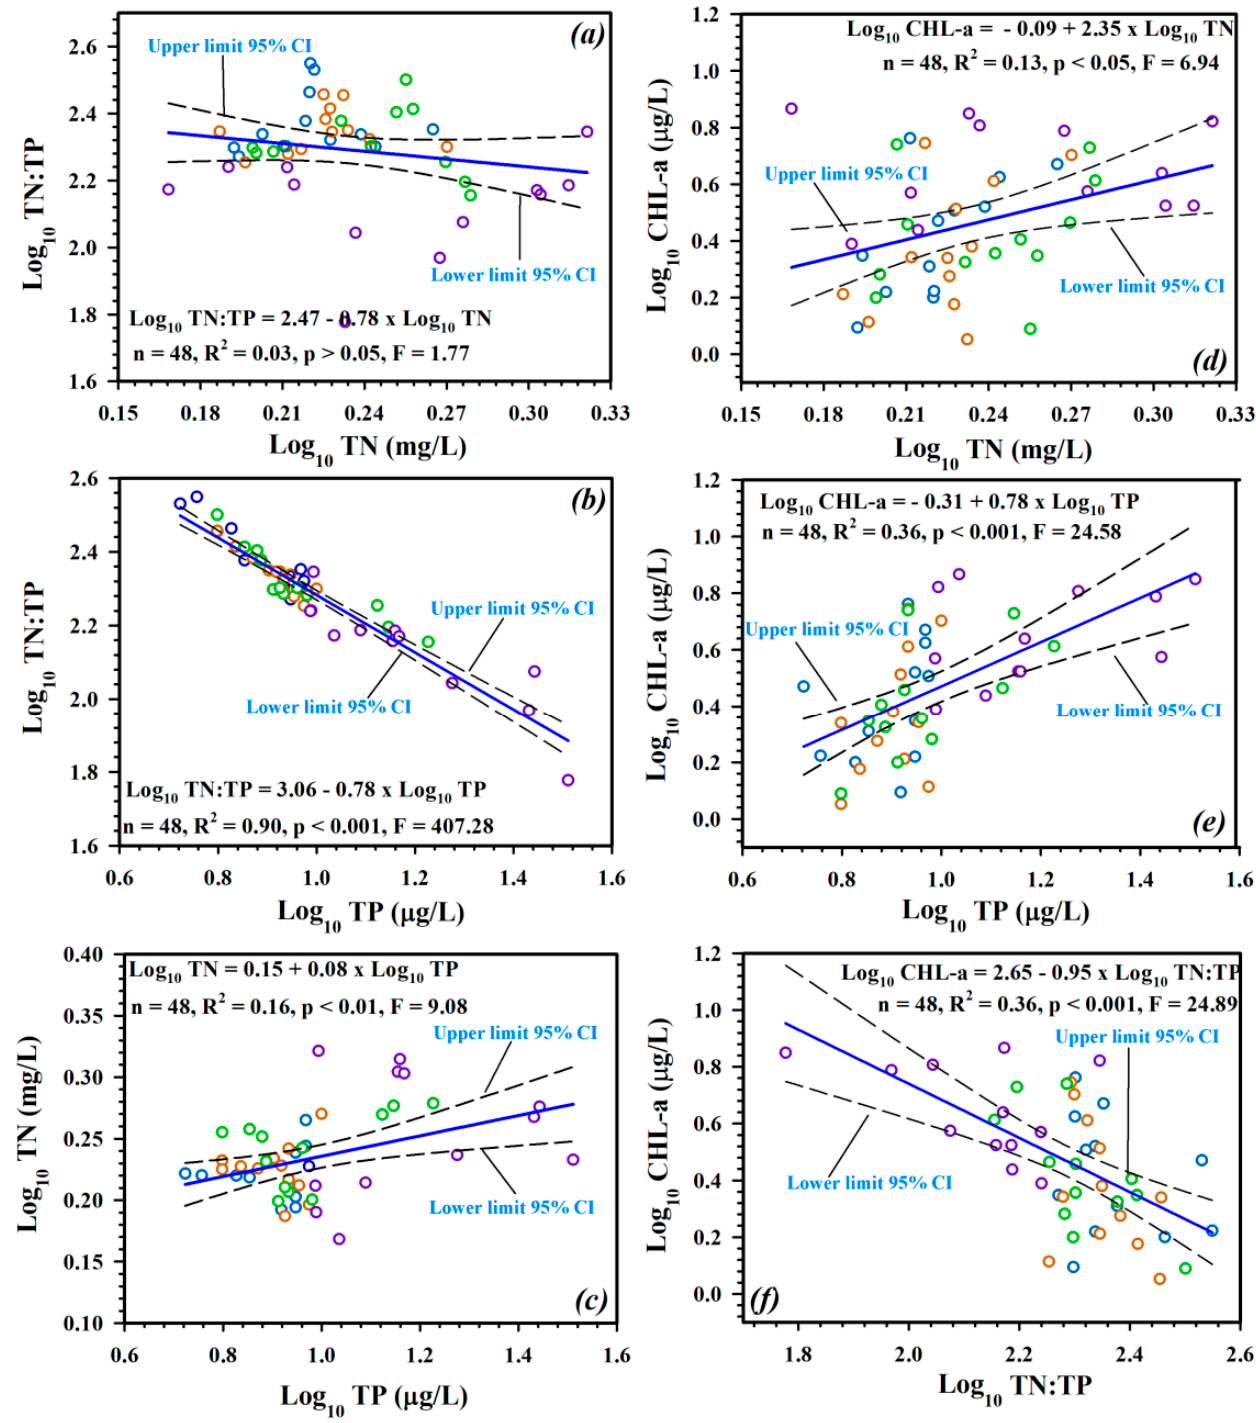
Figure 3. Linear regression models of log-transformed CHL-a, nutrients, and ambient ratio (color meaning: blue–site 1, brown–site 2, green–site 3, pink–site 4).